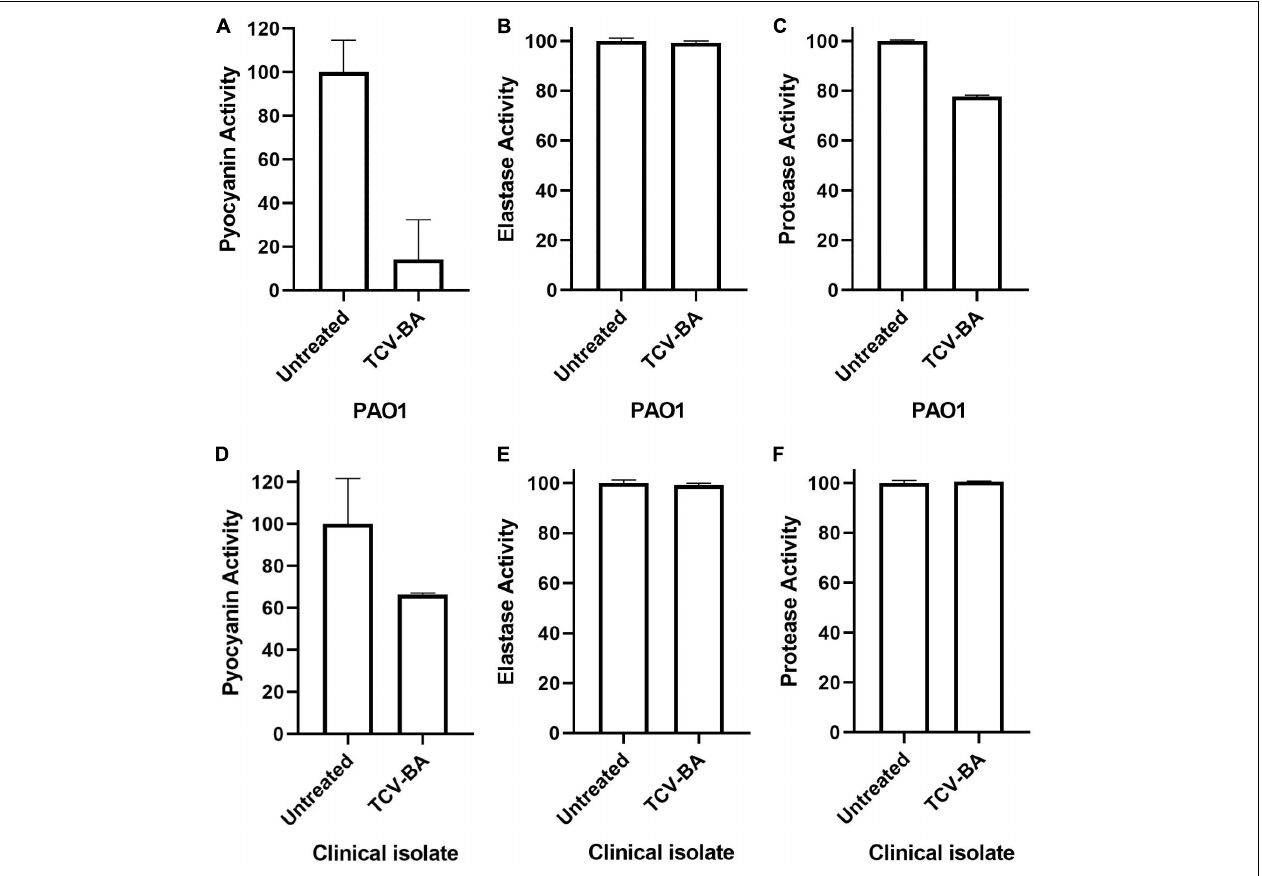
FIGURE 5 | Pyocyanin, protease and elastase inhibition activities of trans- 4-(2-carboxy-vinyl) benzoic acid (TCV-BA) isolated from N. versiforme against PAO1 (A-C) and the clinical isolate (D–F) of P. aeruginosa .